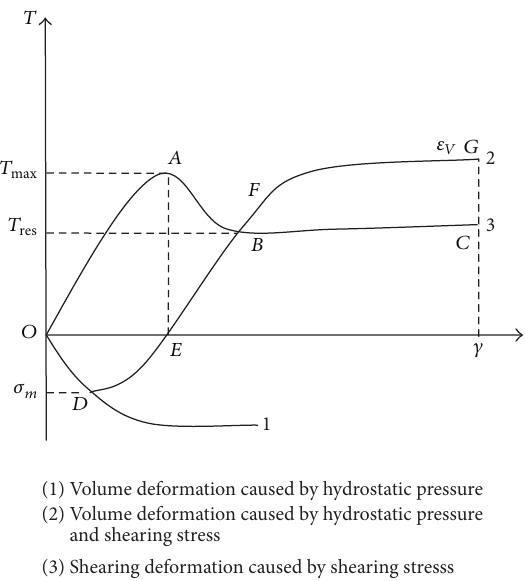
Figure 1: The shearing deformation and volume deformation with shearing